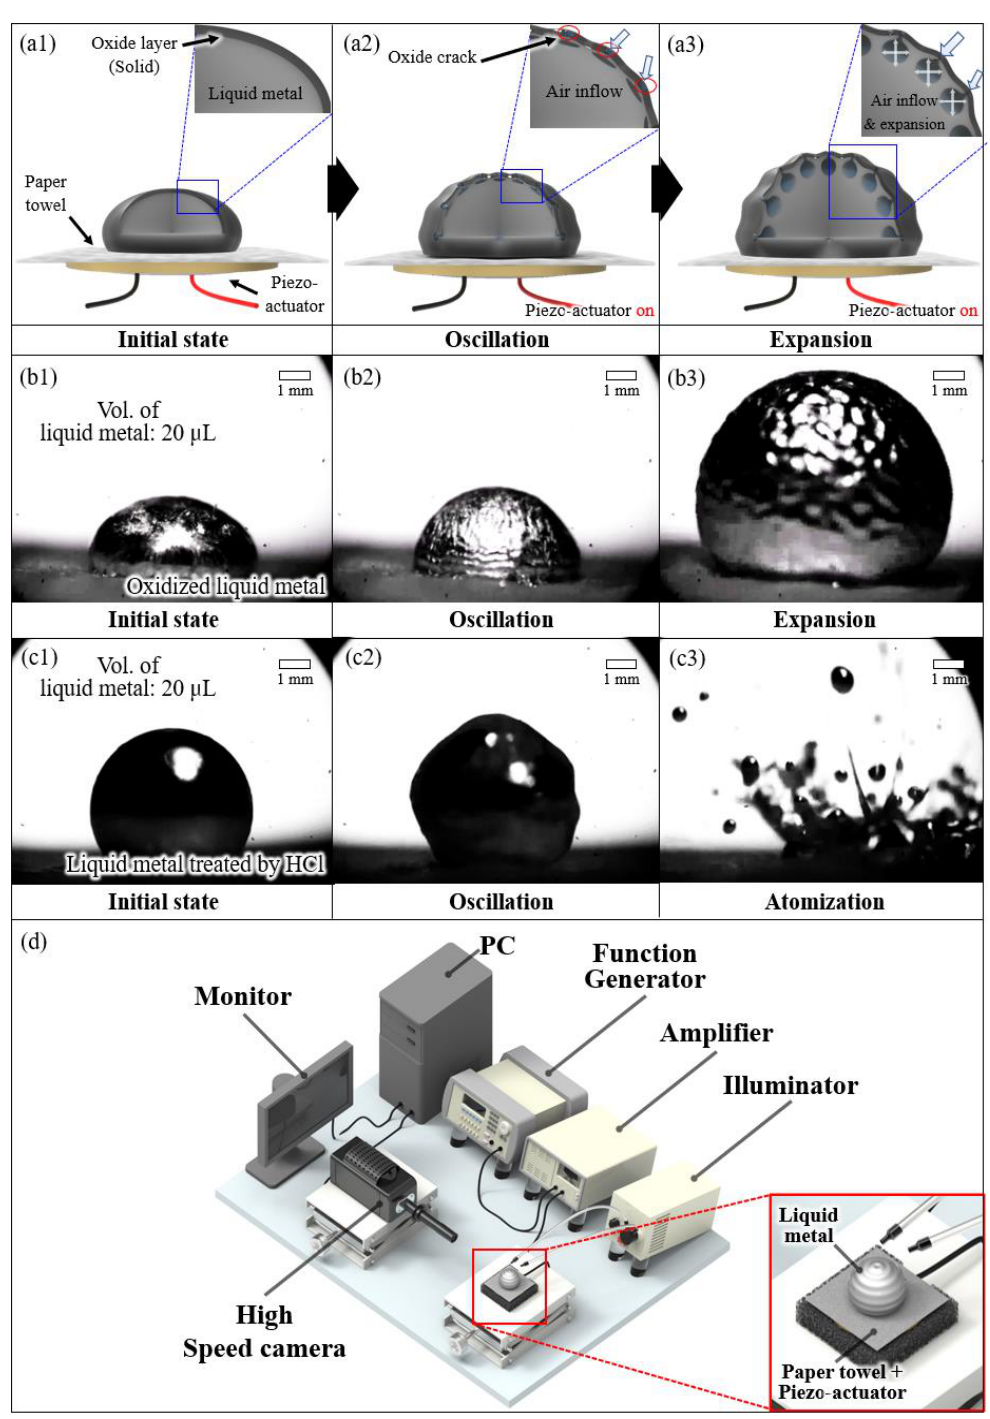
Figure 1. Liquid metal droplet expansion by acoustic wave: ( a ) the conceptual schematic of the liquid metal droplet expansion mechanism, ( b ) captured images of an expanded liquid metal droplet, ( c ) captured images of separated droplets for liquid metal treated with HCl, and ( d ) a schematic diagram of experimental setup.